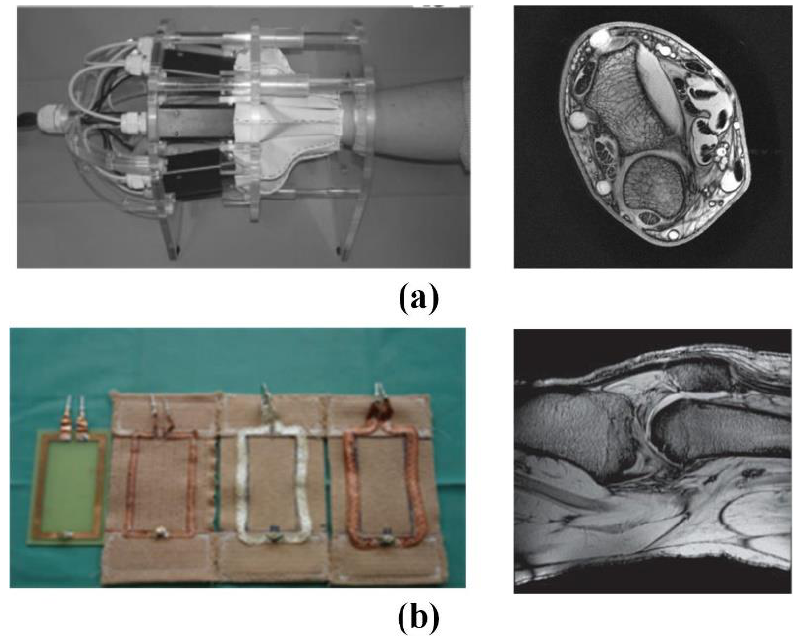
Figure 15. The adjustable mechanical structure for MRI. ( a ) Wrist coil and corresponding detection results. Adapted with permission from ref. [118]. Copyright 2009 Wiley-Liss. ( b ) Knee joint coil, consisting of the reference coil made from circuit and stretchable coils made from 5 mm, 7 mm, and 9 mm copper braids, and detection results. Adapted with permission from ref. [119]. Copyright 2012 Wiley-Liss.